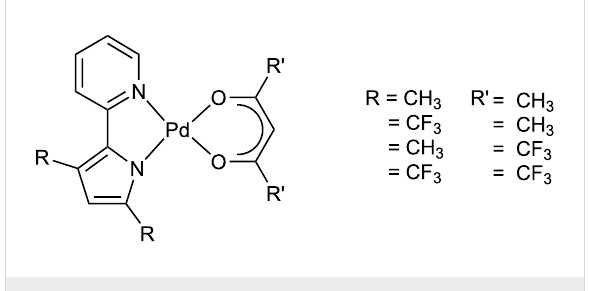
Figure 3: Some unusual palladiomesogens based on 3,5- disubstituted-2,2′-pyridylpyrroles and β-diketonates.